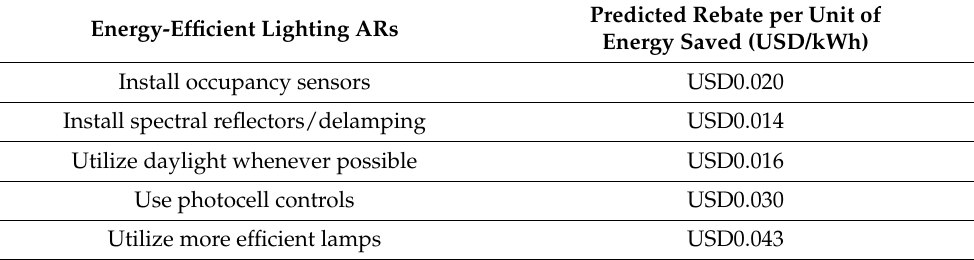
Table 6. Predicted rebate rates for energy-efficient lighting ARs.